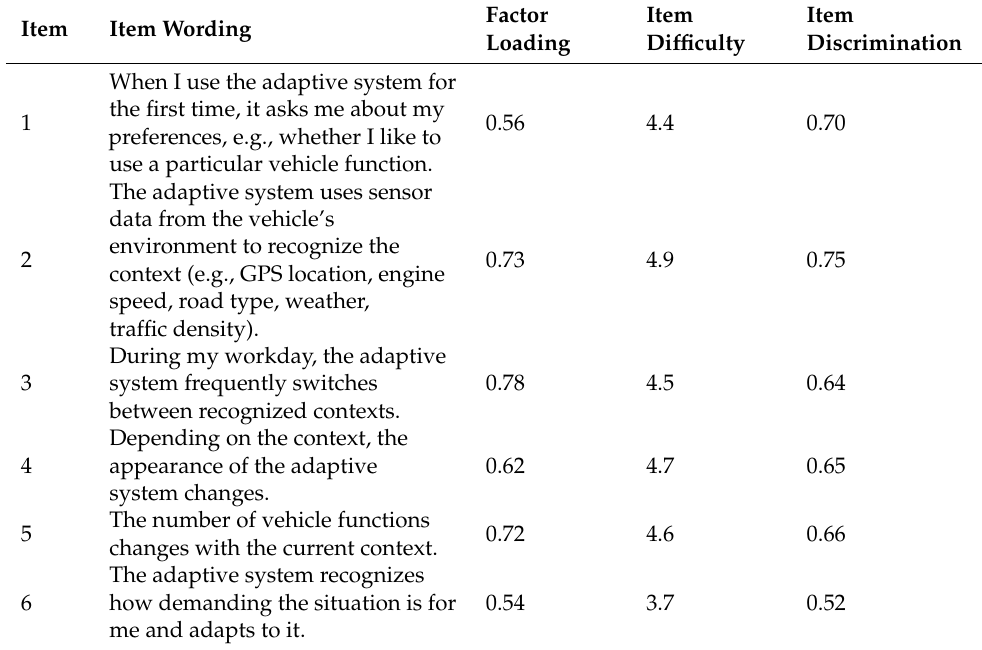
Table A3. Items of Factor 3 “Context